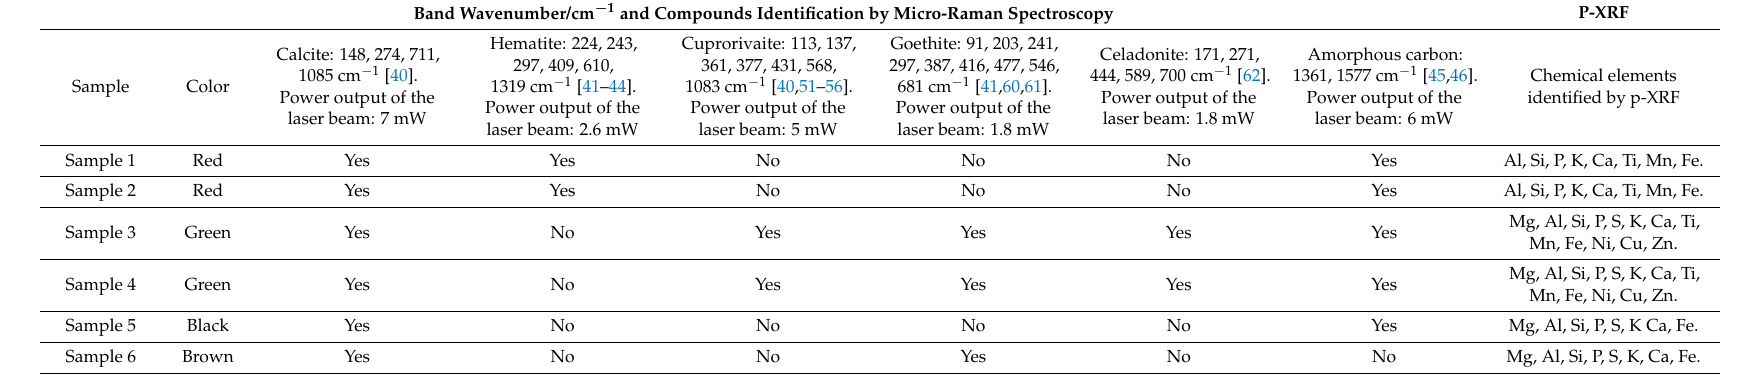
Table 1. Micro-Raman and p-XRF results for the compounds detected on the painted surfaces of all of the samples analyzed in this